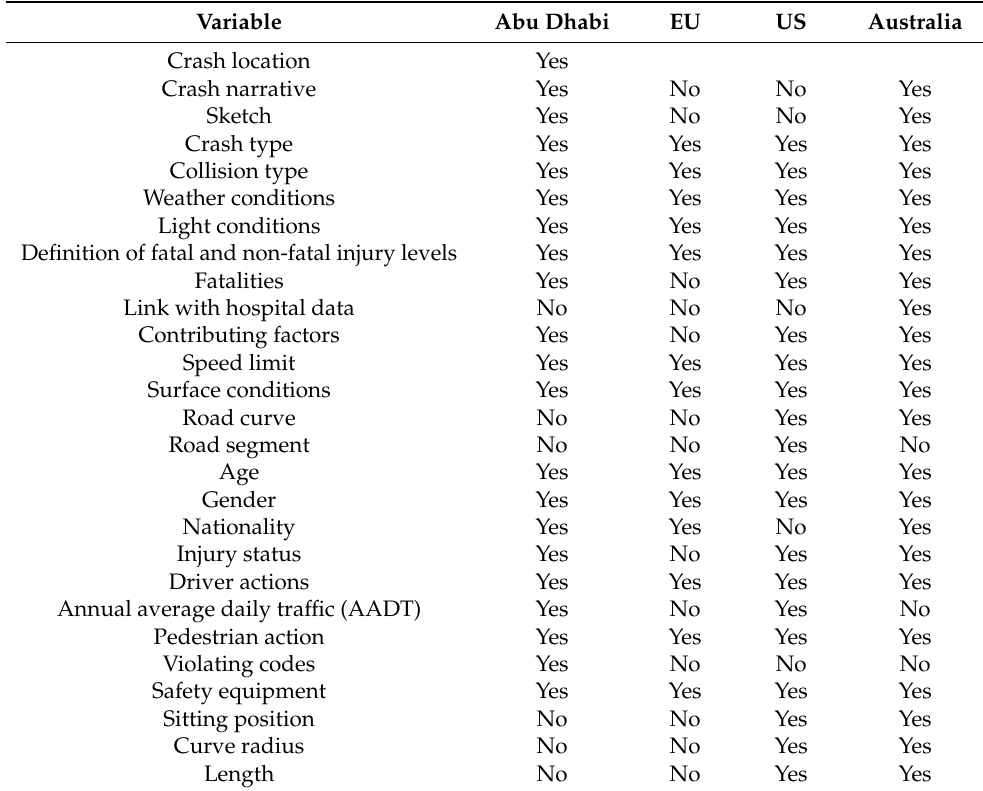
Table 1. Abu Dhabi traffic accident database when compared to other databases; adapted from Casado-Sanz [41].